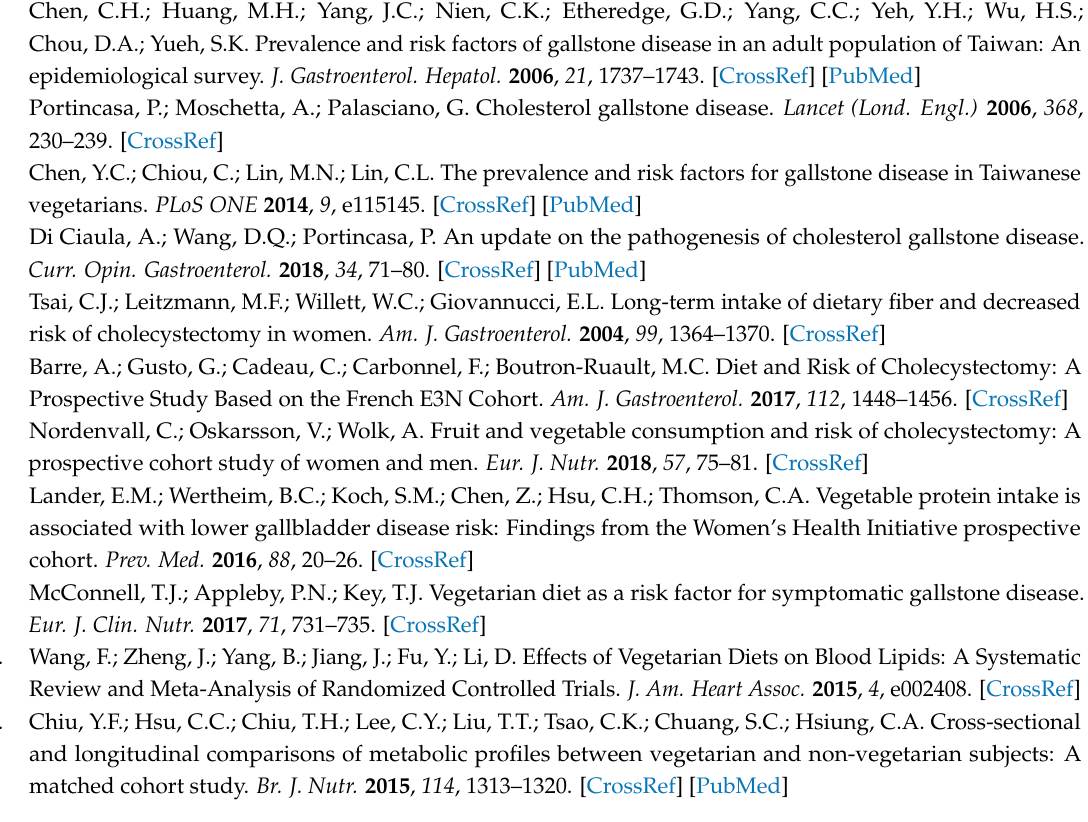
Table S1: Sensitivity test by eliminating symptomatic GSD cases diagnosed within one year of